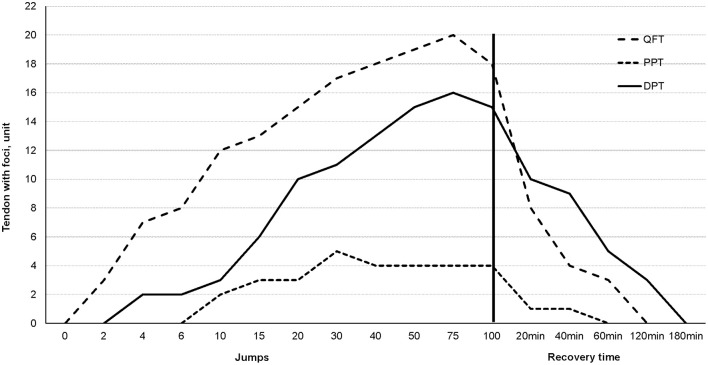
A diagram representing the expression of intratendinous foci during the third intervention. The vertical black line indicates the end of the exercise and the beginning of relaxation.